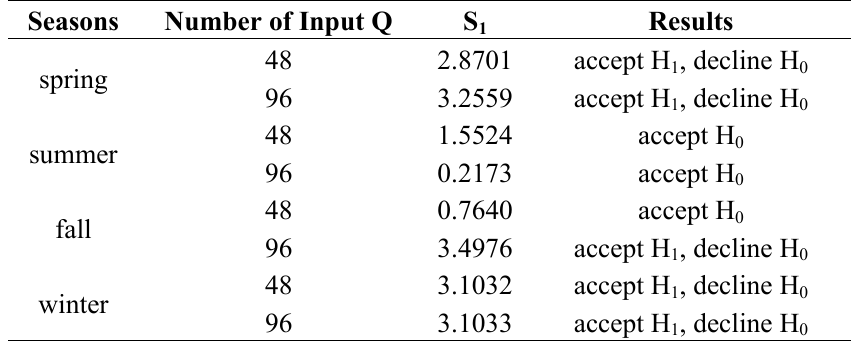
Table 13. Diebold and Mariano test between the proposed hybrid PCA and BP-based neural network (Fisk).